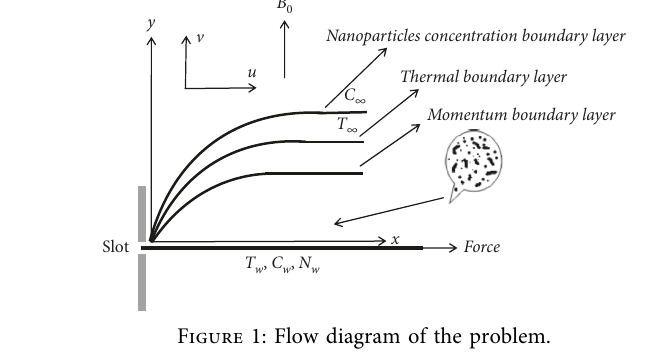
Figure 1: Flow diagram of the